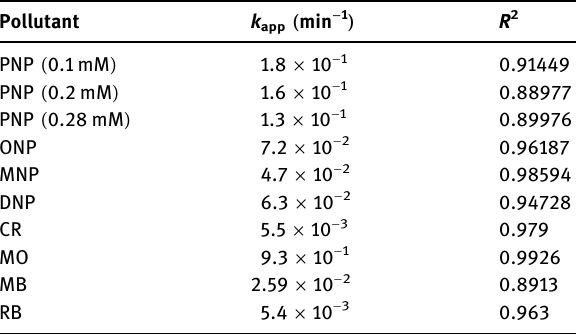
Table 2: The k app and R 2 values the pollutant were derived from the